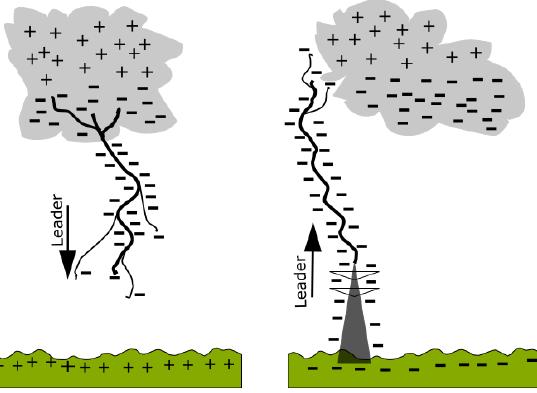
Figure 1. Lightning discharge mechanism.